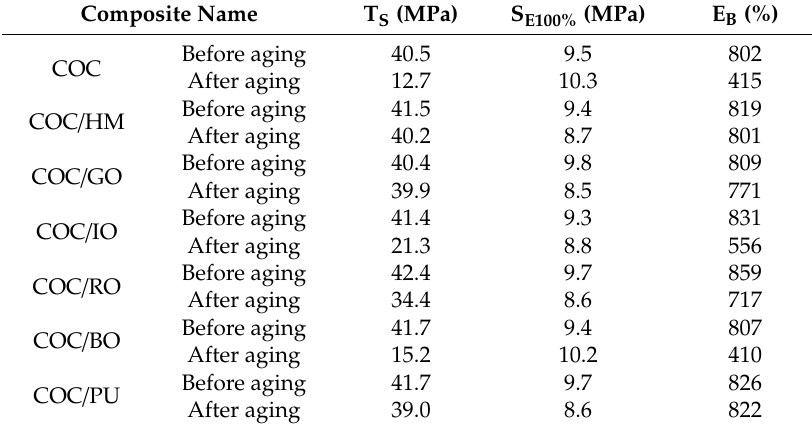
Table 2. Mechanical parameters of the studied composites in their initial state and after 500 h of aging